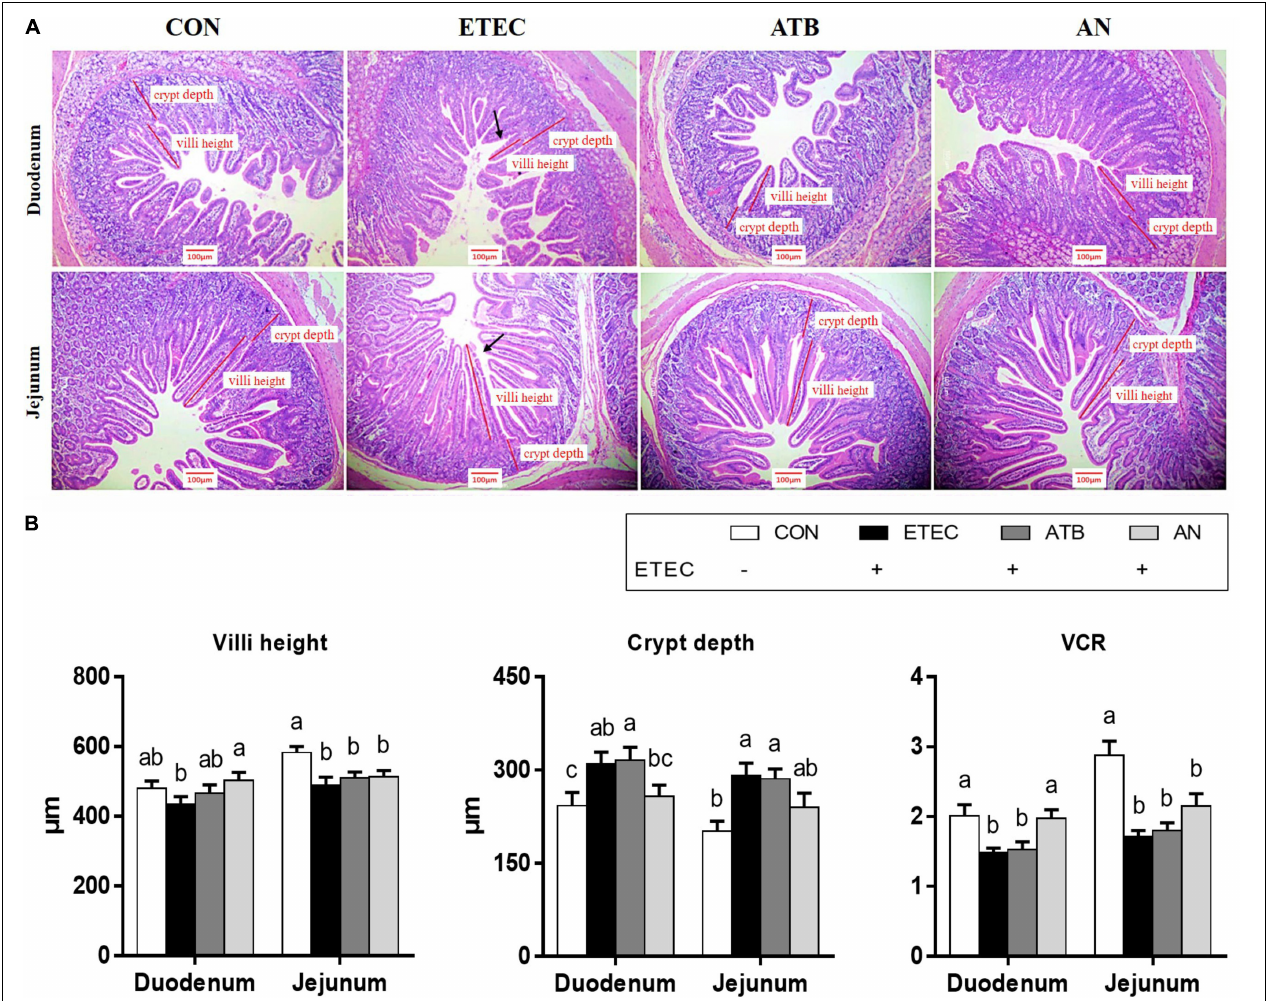
FIGURE 1 | Effects of anethole on intestinal morphology of piglets challenged with enterotoxigenic Escherichia coli K88. (A) HE staining of intestine (B) Villi height, crypt depth and VCR of intestine. The data in each group is expressed as the mean ± SE ( n = 9). Different letters mean statistically significant difference among the groups ( P <